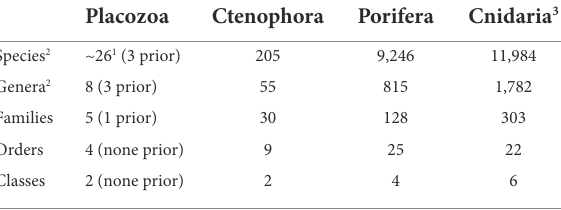
TABLE 2 Number of species and higher taxa in the four early- branching animal